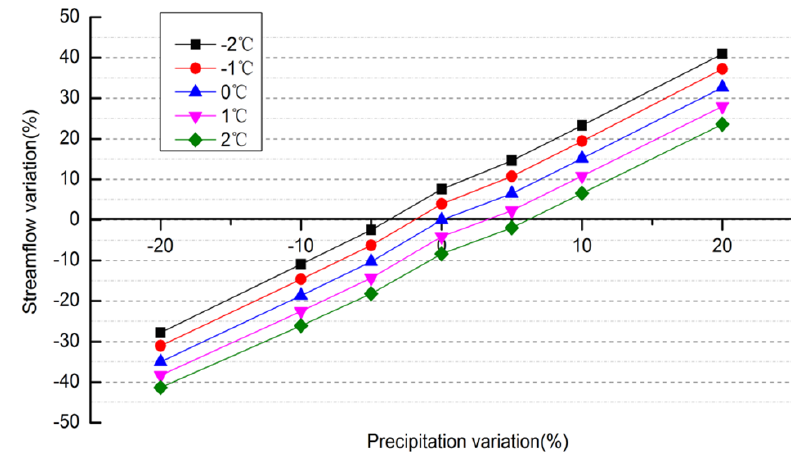
Figure 5. Streamflow under incremental changes of precipitation and temperature.